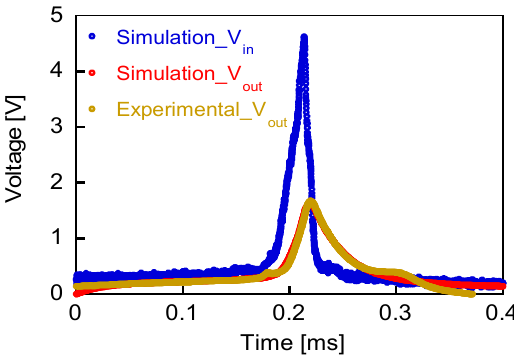
Figure 8. Waveforms of calculated V in , V out , and experimentally measured V out .